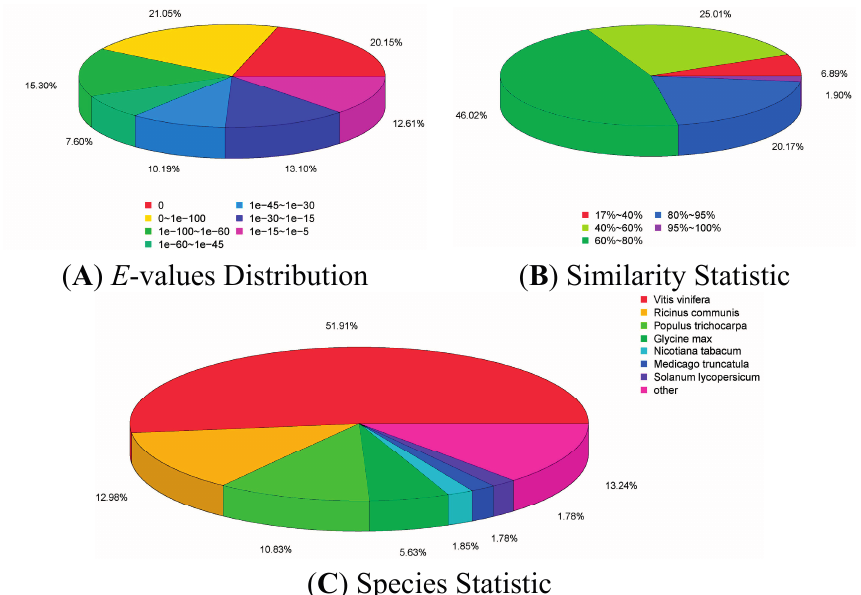
Figure 3. Distribution of E -values ( A ); similarity ( B ); and species ( C ) for the allunigene BLAST (Basic Local Alignment Search Tool) matches against the nr-protein database.